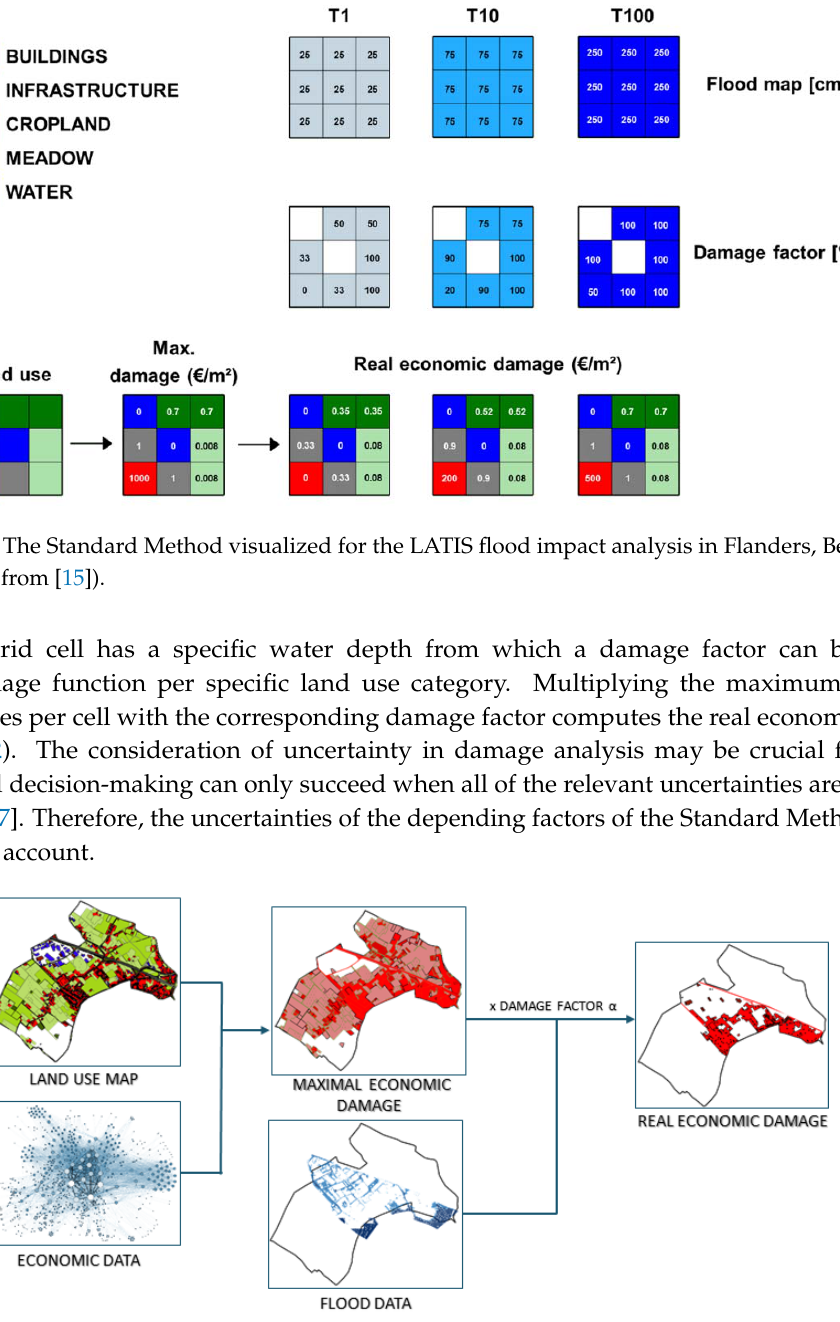
Figure 2. Real economic impact calculation (sample of the Flood Impact Assessment Tool (FLIAT) methodology [18]).